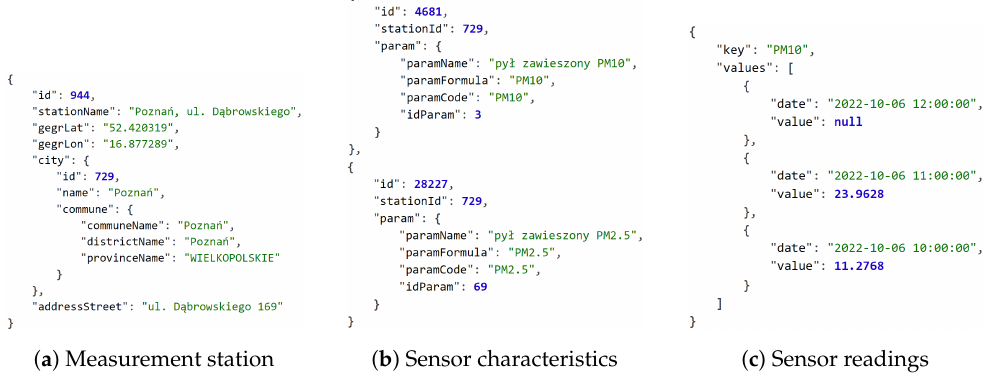
Figure 2. Examples of the data provided by GIO´S Air Quality portal on 6 October 2022